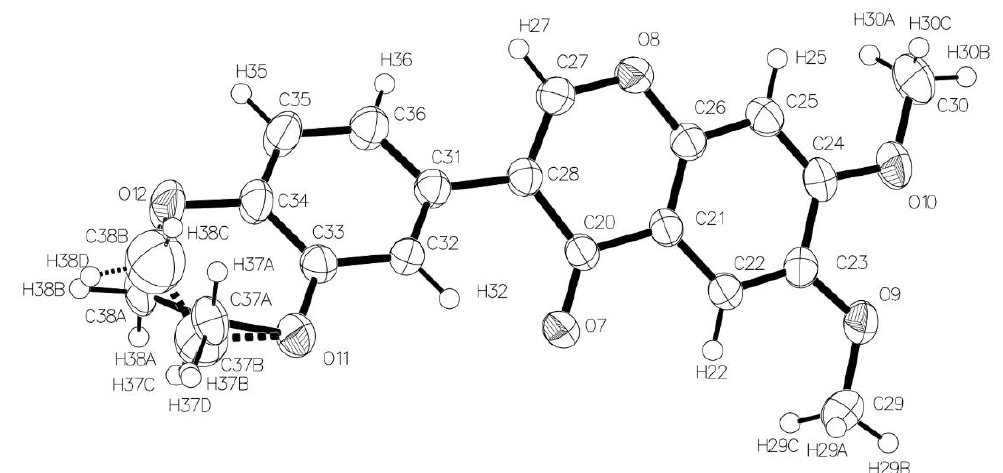
Figure 3. View of the molecular structure of independent molecule 5II with the atom label including all hydrogens. It shows disordered structure in 1, 4-dioxane rings. Displacement ellipsoids are drawn at the 30% probability level.